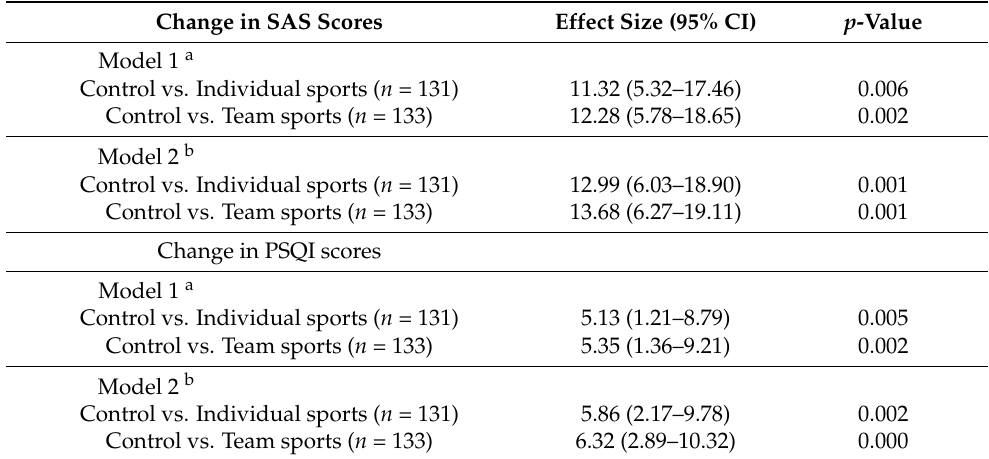
Table 3. Effect of inter-group self-evaluation on depressive symptoms and anxiety